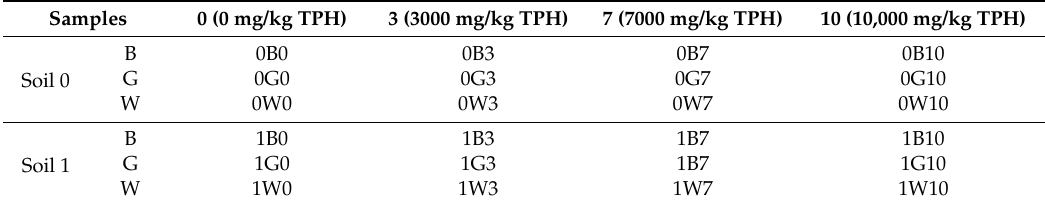
Table 1. Total petroleum hydrocarbon (TPH) treatments for Weihe Terrace soil (Soil 0) and silty loam in Loess tableland (Soil